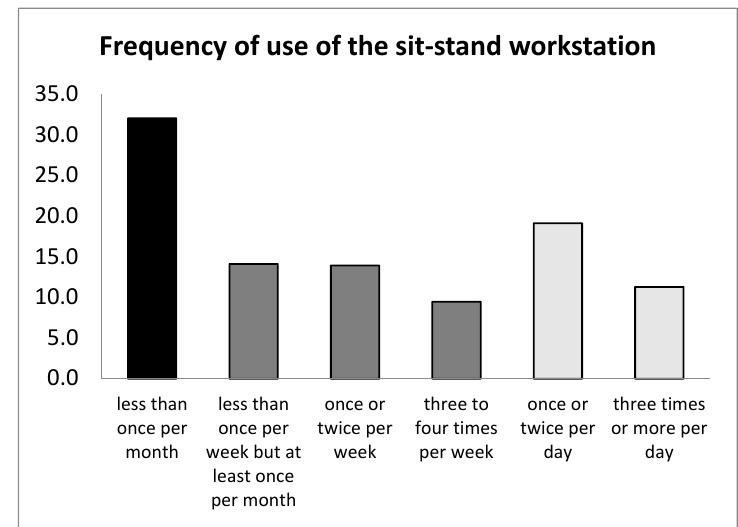
Figure 1. Percentages of self-reported frequency of the use of the sit-stand workstation, with total N = 1098. Black = non-users, dark grey = monthly/weekly users, light grey = daily users.